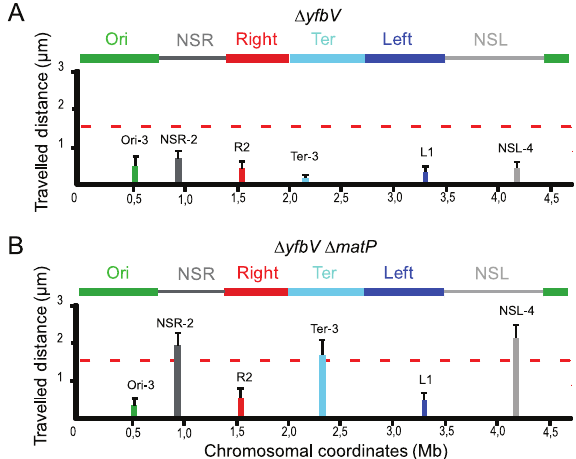
Figure 5. Insulation requires the YfbV protein. Travelled distance of different markers in strains deleted for yfbV or yfbV and matP . The representation is the same as in Figure 2. (A) strain with a deletion of yfbV (markers Ori-3, NSR-2, Right-2 (R2), Ter-3, Left-1 (L1) and NSL-4 are indicated from left to Right). (B) strain with a deletion of yfbV and matP (markers Ori-3, NSR-2, Right-2 (R2), Ter-3, Left-1 (L1) and NSL-4 are indicated from left to right).